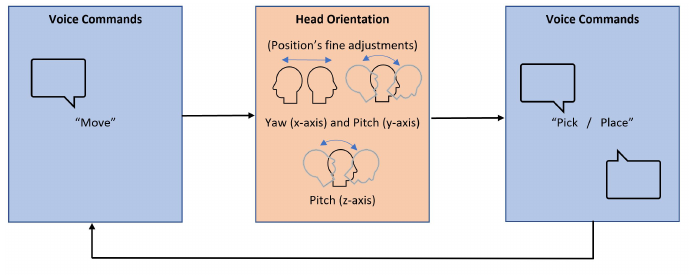
Figure 1. Diagram of the multimodal hands-free